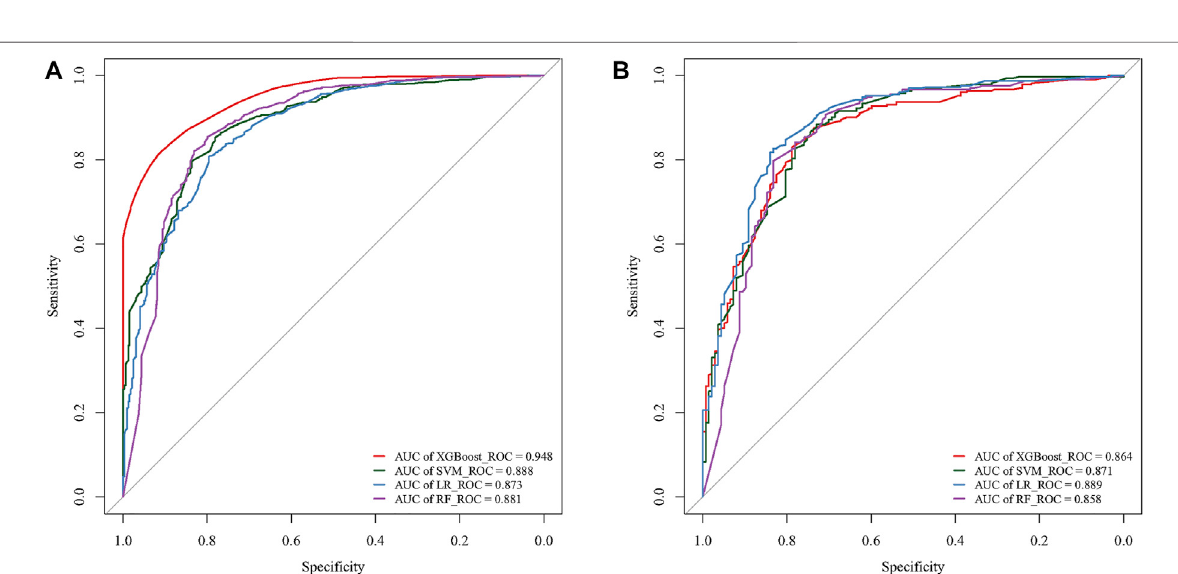
Frontiers in Genetics |